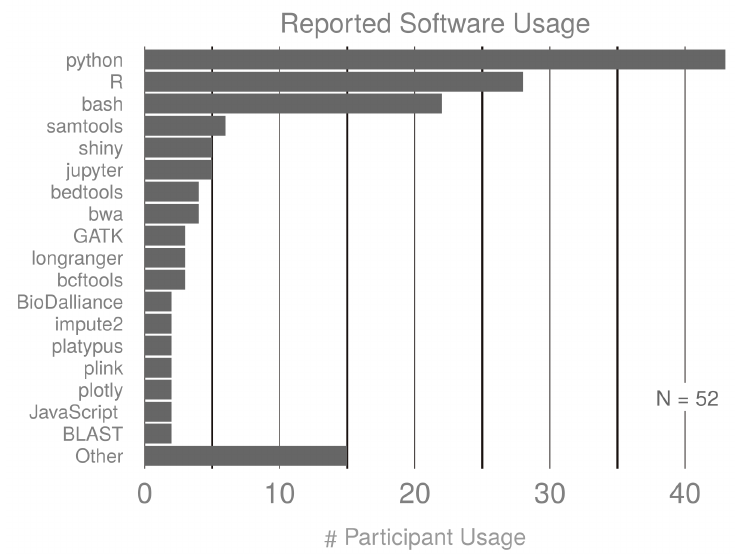
Figure 2. Software usage during hackseq 16. At the conclusion of hackseq, we asked participants to complete a survey on their experience at hackseq. There were 52 responses to the question, “Which programming languages and tools did you and your team use during the course of hackseq? (Comma delimited please).” These responses were parsed and the number of unique instances is reported. Languages or software listed <2 is reported as